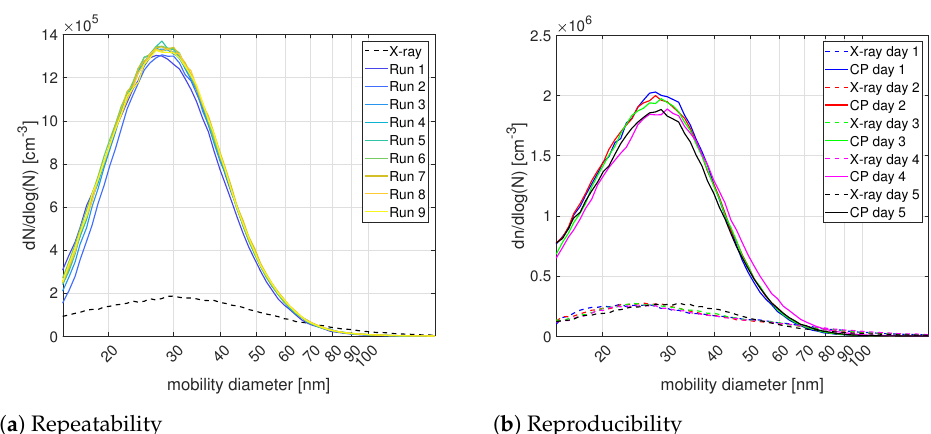
Figure 4. Particle size distribution measurements with both the X-ray charger and the CeraPlas ® . ( a ) Nine repetitions of size distribution measurement using the CeraPlas ® for particle charging. The measurements were performed in a 10min interval. A reference measurement with the X-ray charger was done before Run 1. The settings of the particle generator were not changed. ( b ) Particle size distributions for NaCl particles, measured with CeraPlas ® and X-ray charger. Size distribution curves have been measured on several days to ensure